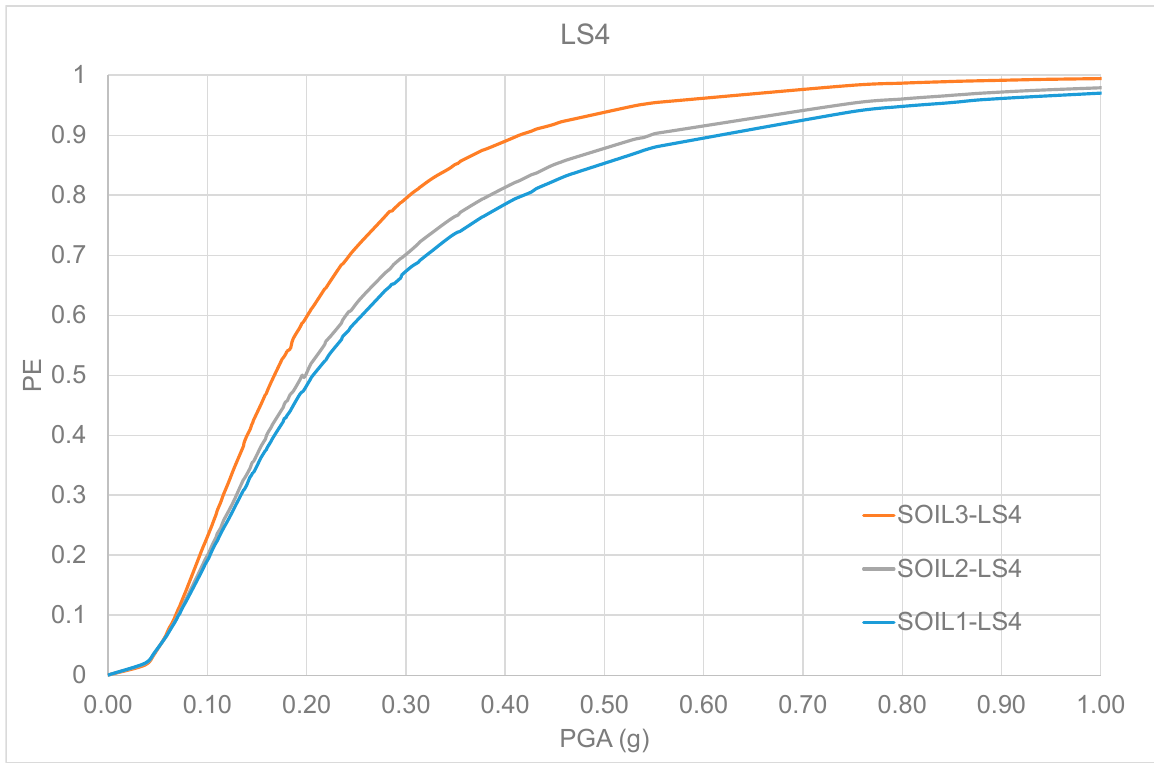
J. Mar. Sci. Eng. 2022 , 10 , x FOR PEER REVIEW Figure 10. Fragility Curves: comparison LS4. Figure 10. Fragility Curves: comparison LS4.